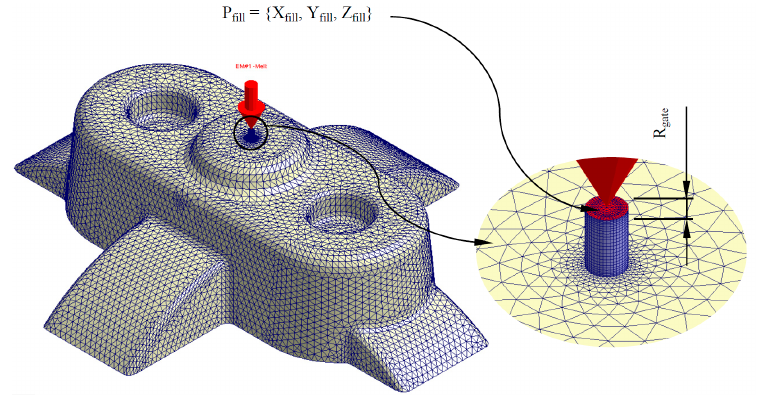
Figure 3. Discrete geometry P’ ∈ ℝ 3 of the plastic part and detail of the filling injection point and injection mold gate.